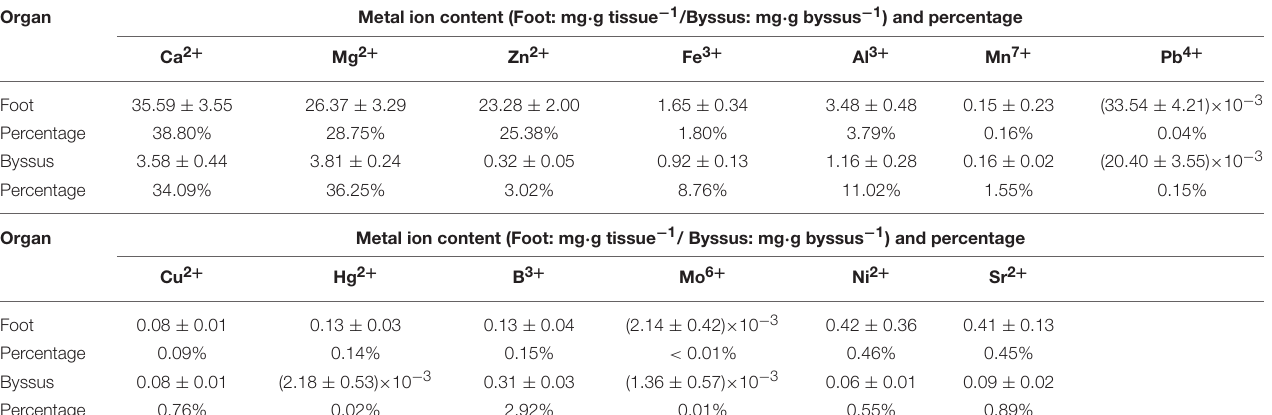
TABLE 3 | Metal ion contents in foot tissue and byssus of the golden mussel Limnoperna fortunei as detected by inductively coupled plasma mass spectrometry.